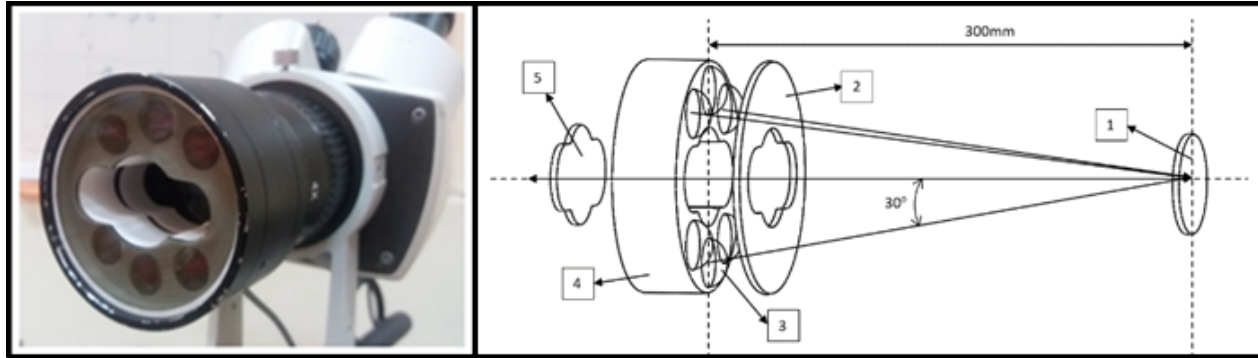
Fig. 1. Polarized light source for colposcope: (1) Region of interest; (2) The ¯rst polarizer; (3) LEDs, (4) The body of light source and (5)